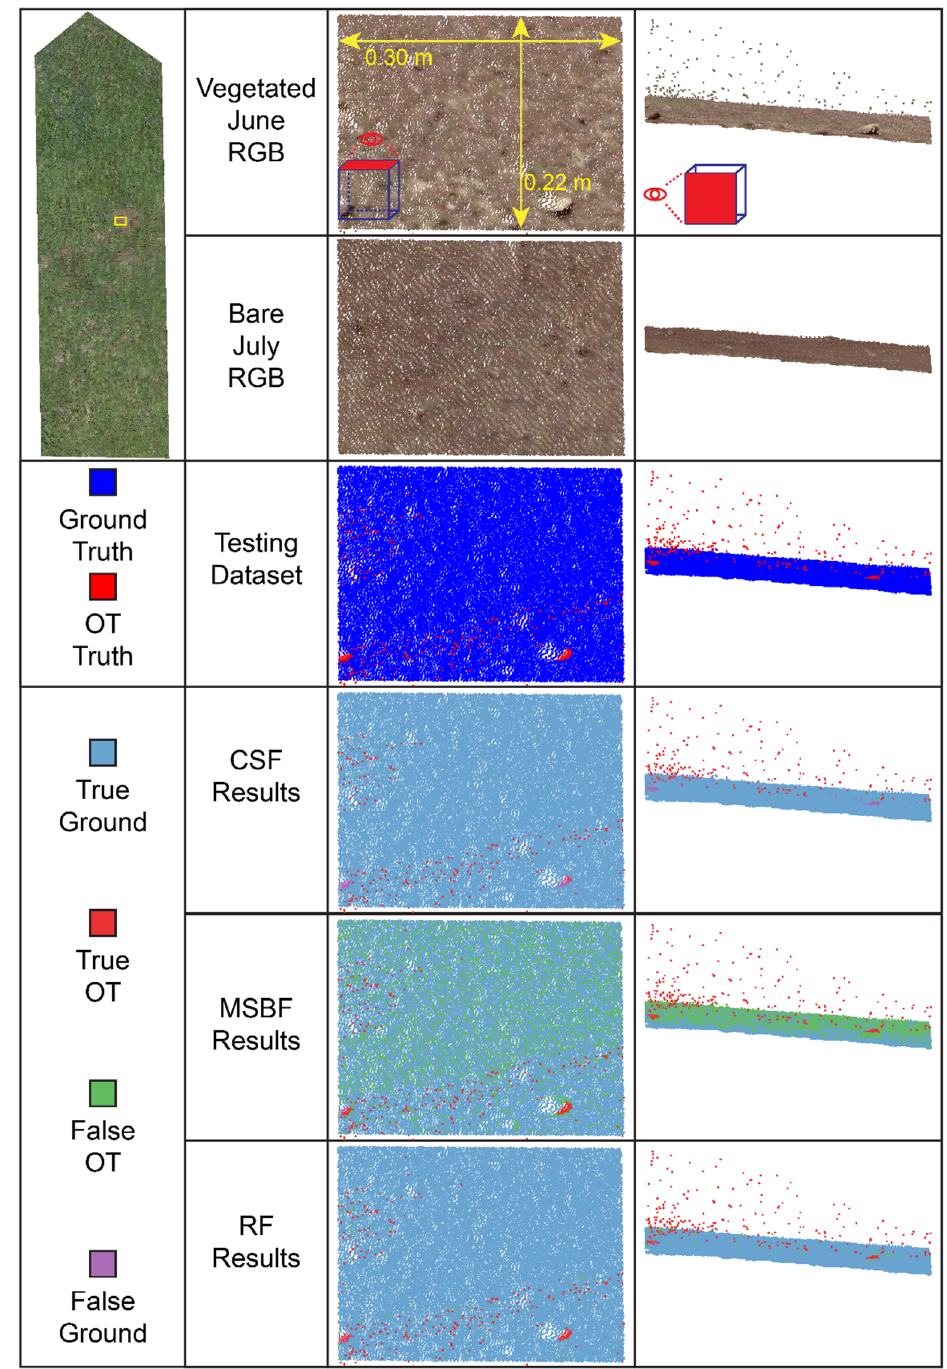
Figure 10. Filtering results on a bare portion of the plot.